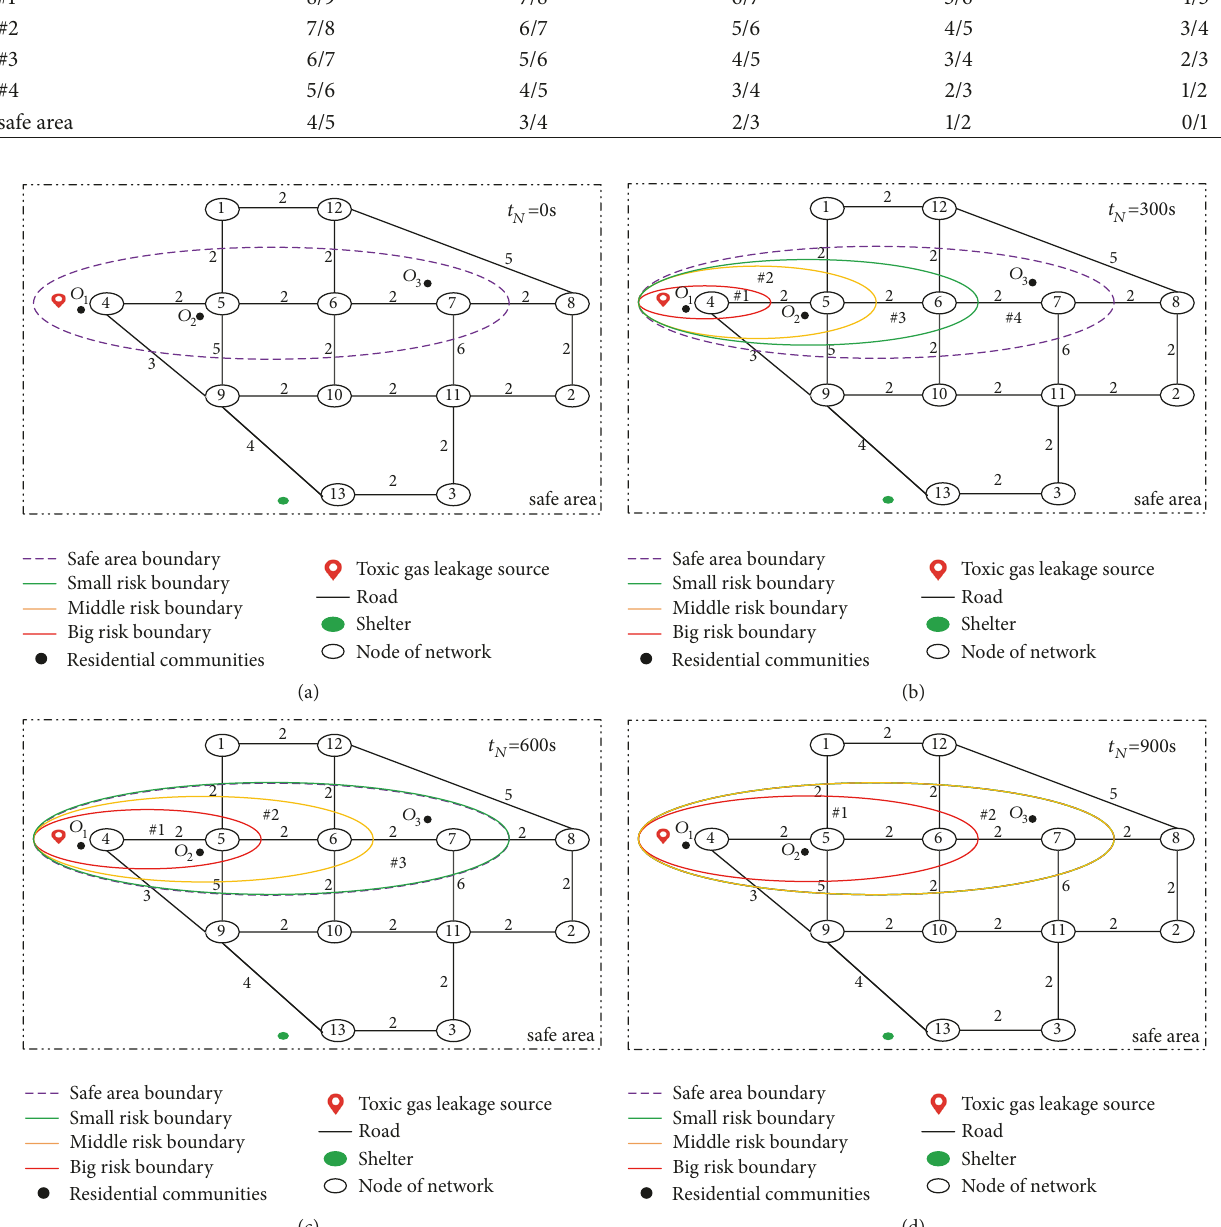
Figure 3: Gas diffusion on Nguyen and Dupuis network: (a) t =0s; (b) t =300s; (c) t =600s; (d) t =900s.